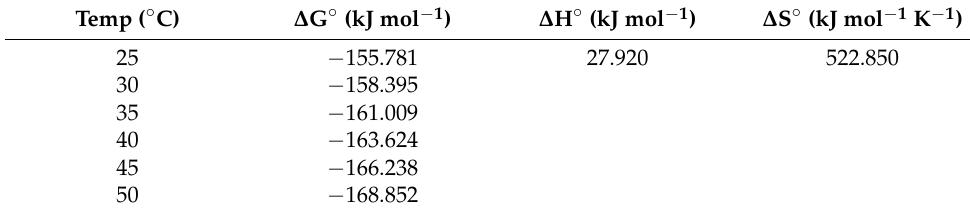
Figure 4. Effect of temperature on the dicamba adsorption (concentration of dicamba, 20 mg L − 1 ; equilibration time, 25 min ; rpm, 150). Table 3. Thermodynamic parameters for the adsorption of dicamba onto MIL-101(Cr).